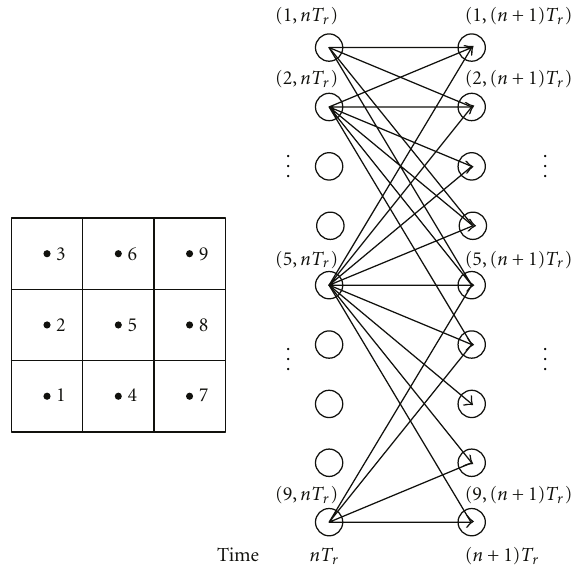
Figure 7: Vertex and edge assignment of the expansion graph from time nT r to time ( n + 1) T r for 3 × 3 square grid; edge weights are not marked. Note that the vertex (5, nT r ) at time nT r corresponds to a nonboundary cell of the considered grid, and it has 9 outgoing edges from time nT r to ( n + 1) T r . All the other vertices at time nT r correspond to boundary cells. For vertices (1, nT r ), (3, nT r ), (7, nT r ), and (9, nT r ) at time nT r , they have 4 outgoing edges while for vertices (2, nT r ), (4, nT r ), (6, nT r ), and (8, nT r ), they have 6 outgoing edges from time nT r to ( n + 1) T r